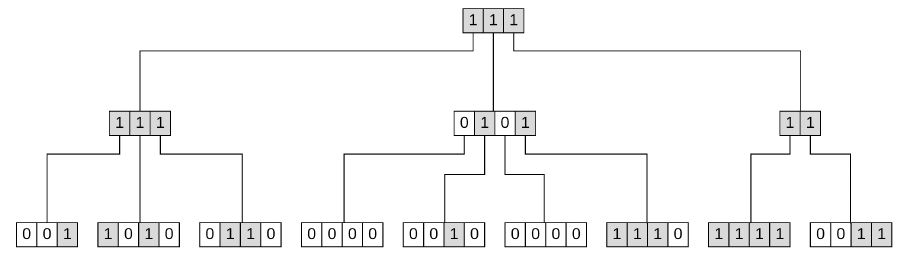
Figure 2. Bit Vector Representation.